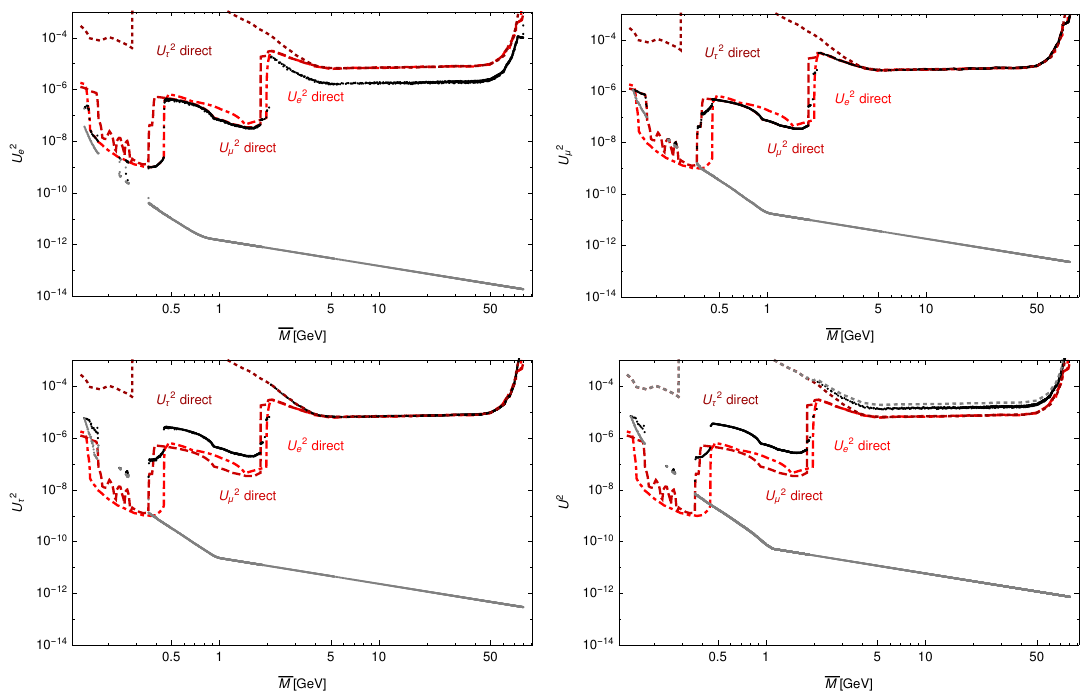
Figure 2 . Global constraints from direct and indirect search experiments and BBN for normal hierarchy and (cid:1) M < 10 MeV. The black and grey dots mark the largest and smallest value of U 2 and U 2 we found to be consistent with all constraints in each mass bin. For comparison, the red lines show the direct search constraints from collider and (cid:12)xed target experiments on U 2 dotted), U 2 (dashed) and U 2 (dotted) alone. In the plot for U 2 we also added their sum as dashed (cid:22) (cid:28) grey